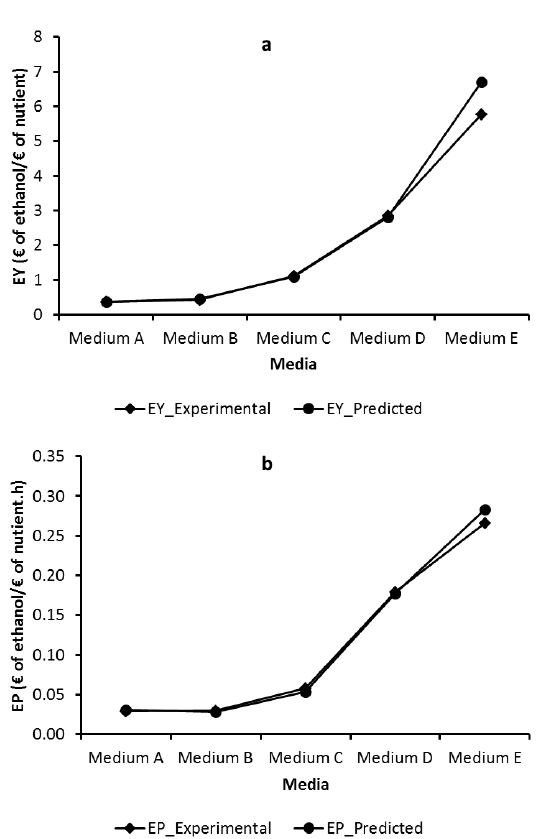
Figure 4. Economic yield (EY, a) and economic productivity (EP, b) of ethanol on different nutritional compositions. Table 4. Cost of nutrients used in different media compositions.